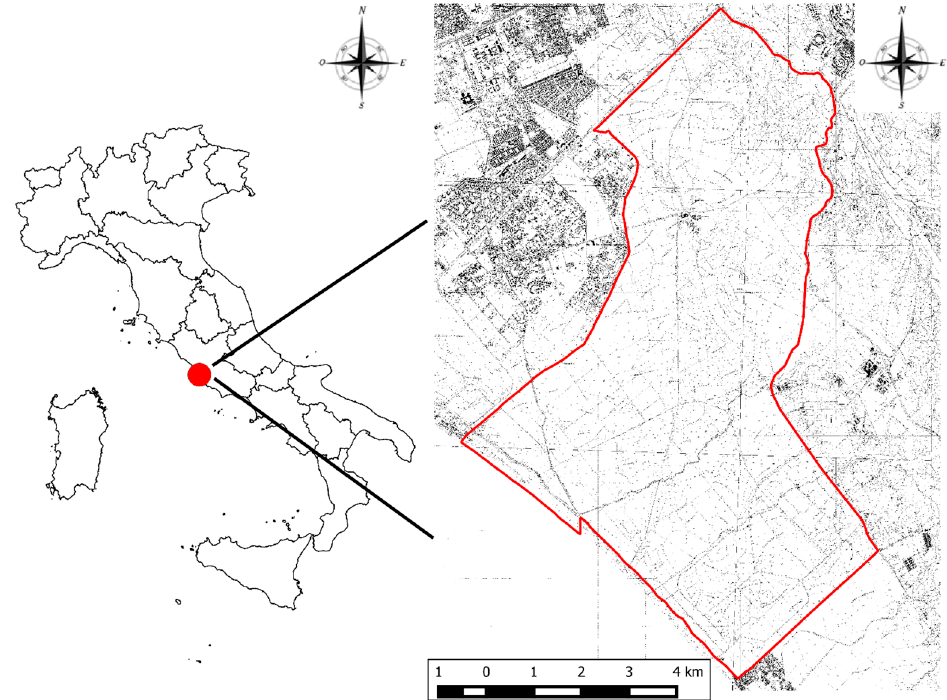
Figure 1. Study area location and overlaying on topographic map developed using QGIS 2.18 Software (Las Palmas, open source). GIS elaborations were performed with Coordinate Reference System CRS: WGS84UTM33T, Geodetic Parameter Dataset EPSG (European Petroleum Survey Group): 32633.